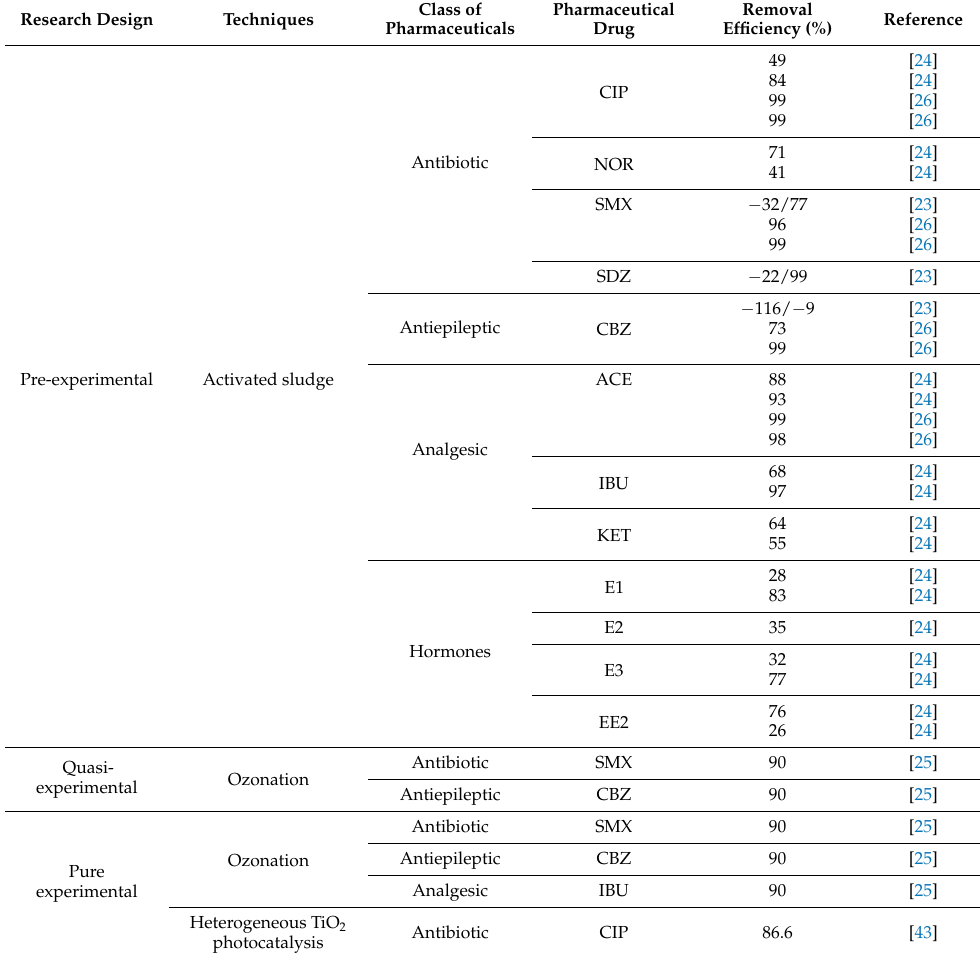
Table 7. Removal of pharmaceuticals from hospital